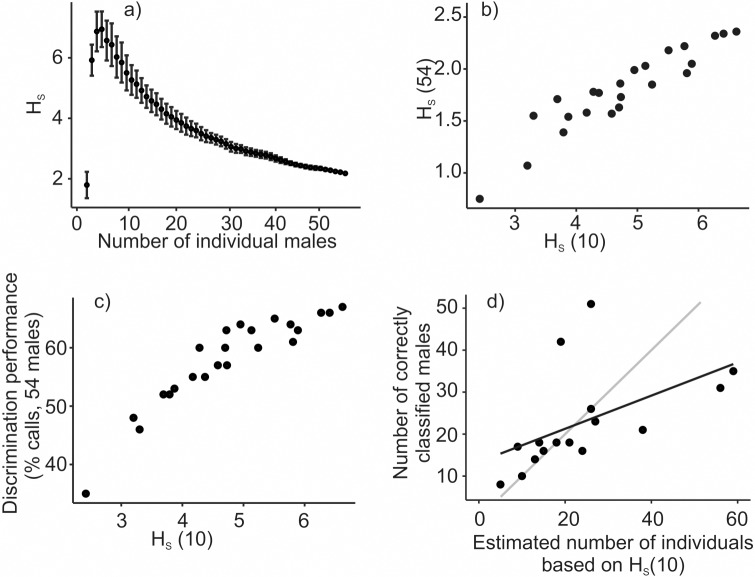
Relationship between the HS and population size to be monitored.(a) HS as a function of the number of individuals in the sample. (b) Relationship between average HS computed from subsample of 10 random individuals HS(10) or full sample of 54 males HS(54). (c) Relationship between HS and call discrimination performance. (d) Relationship between the estimated and real number of discriminated individuals. Grey line illustrates y = x line for ideal estimates. HS in (b), (c), and (d) was computed for 23 discrimination models that differed in how many and which measuring points (F1 –F20) were included (S1 Table).